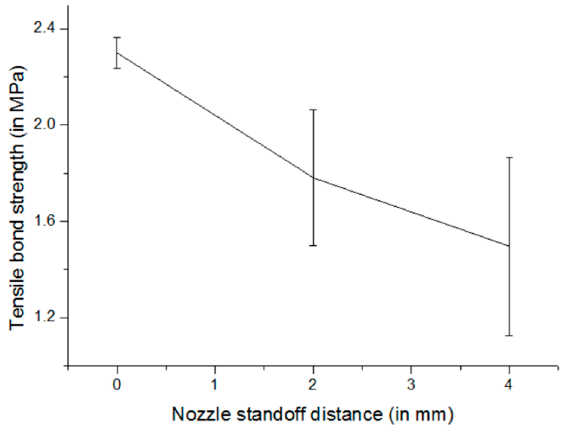
Figure 16. Effect of nozzle standoff distance on tensile bond strength. Reprinted with permission from ref. [43]. Copyright 2017 Elsevier